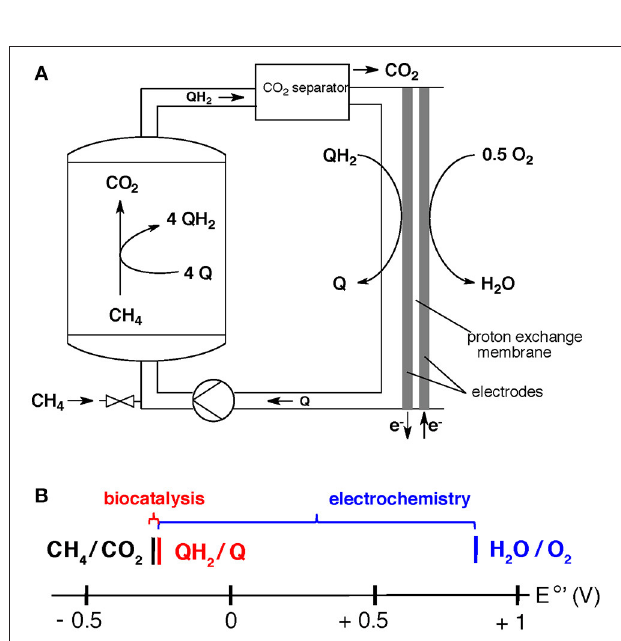
FIGURE 2 | (A) Proposed system for electricity generation from methane via a two-step process involving biocatalysis (left side) and electrochemistry (right side) ( Scheller et al., 2018). (B) Division of energy (redox-potential difference) from methane oxidation with air (equation 5) into a biochemical step of fuel conversion (red, equation 6), followed by an electrochemical step of electricity harvest (blue, equation